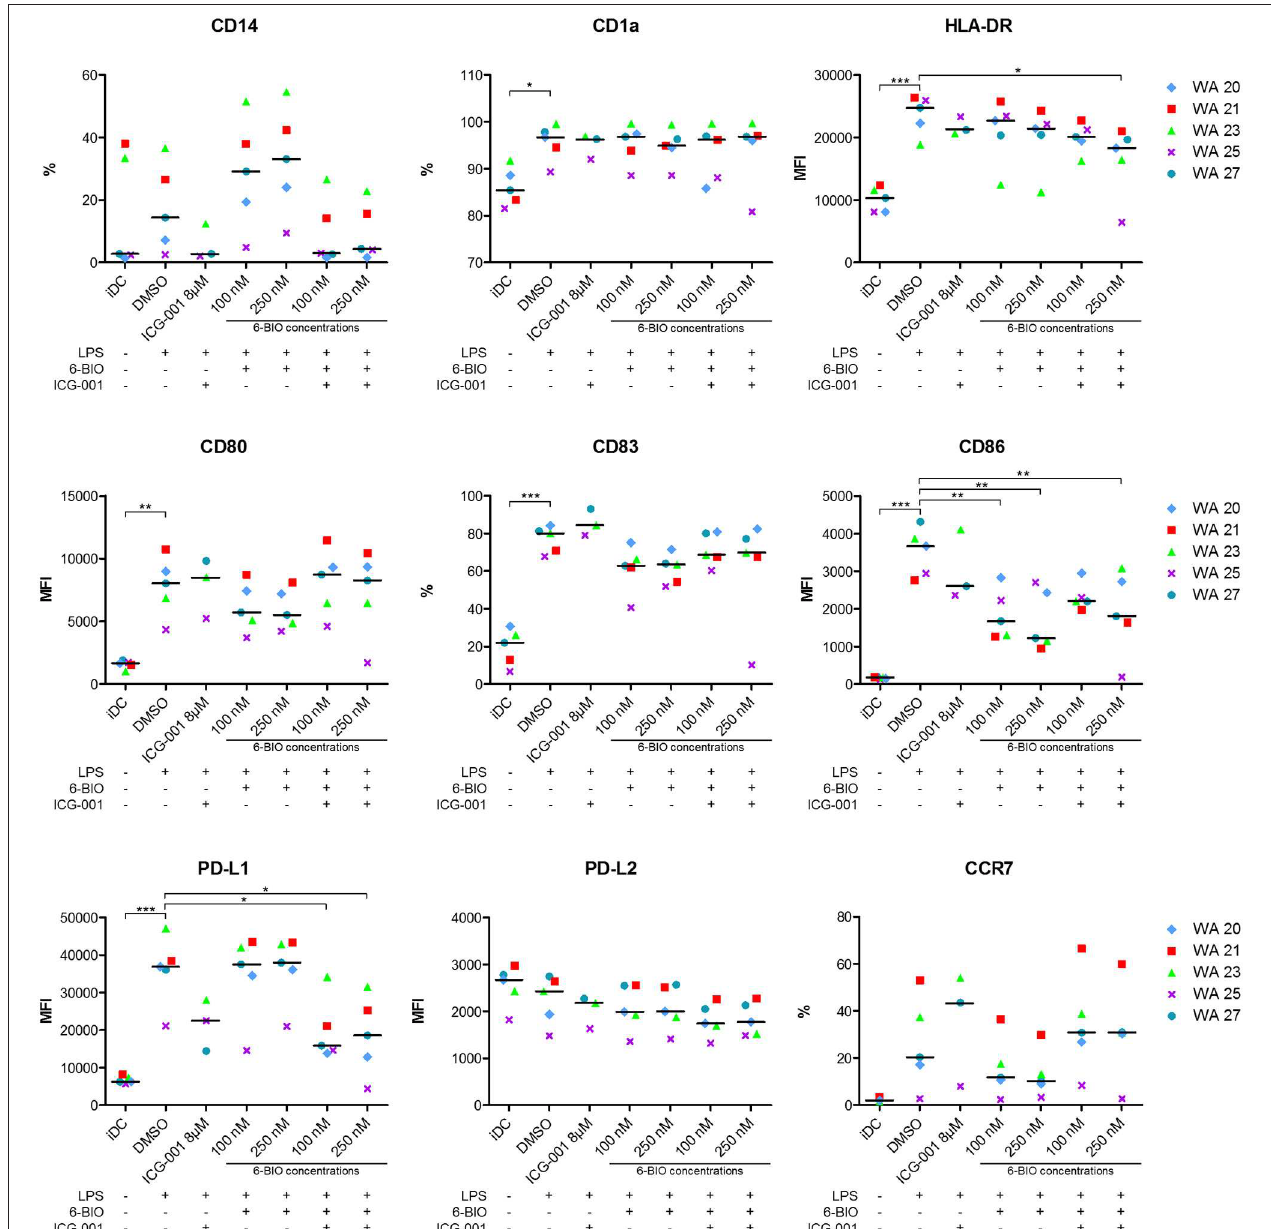
FIGURE 4 | moDCs obtained from healthy donors were treated with 8 µ M ICG-001 and/or indicated concentrations of 6-BIO or DMSO for 24h with 30ng/ml of LPS for the last 23h or left untreated as iDC. Flow cytometry analyses of cell surface markers were performed. Each symbol represents a different donor and lines represent the median. * P ≤ 0.05, ** P ≤ 0.01, *** P ≤ 0.001, using one-way ANOVA with Dunnett’s multiple comparisons test and 95% confidence interval. %, percentage of positive cells; MFI, median fluorescence